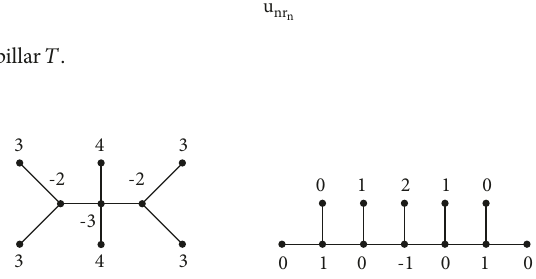
Figure 3: Two examples with solutions to the SACP on 𝑍 𝑚